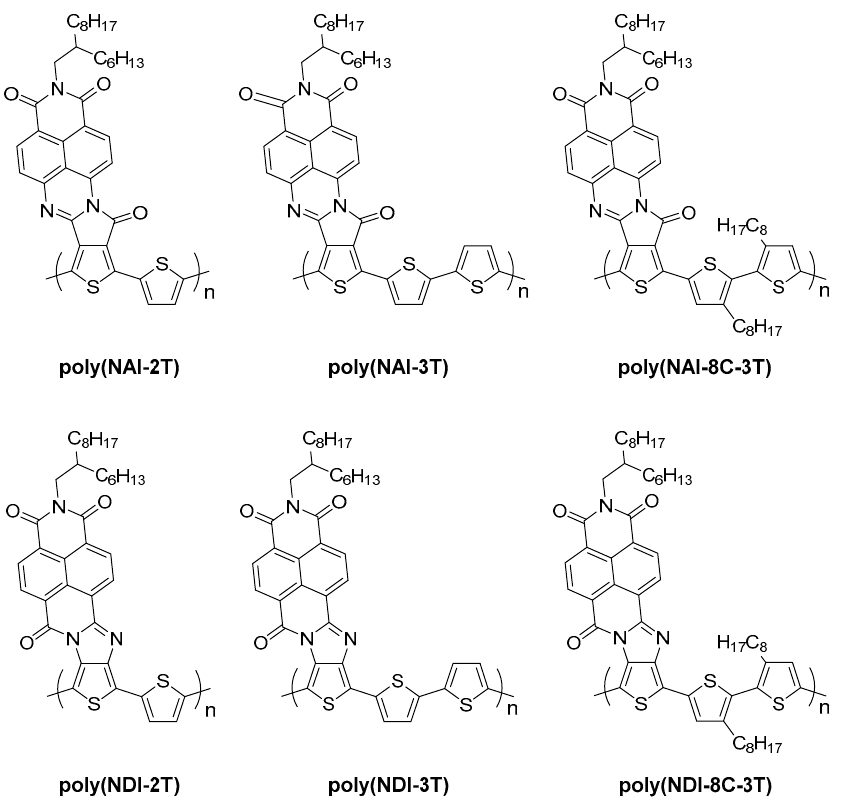
Figure 10. Different organic polymers based on NAI-nT and NDI-nT semiconductors. The polymers could be obtained by Stille cross-coupling reactions between NAI-1T- 2Br (Scheme 5) or NDI-1T-2Br (Scheme 3) and the corresponding thiophene or bithiophene bisstanannes. Due to the low solubility of poly(NDI-3T) and poly(NAI-3T) derivatives, alkyl chains were introduced in the bithiophene comonomer to obtain more processable materials, designated as poly(NDI-8C-3T) and poly(NAI-8C-3T) (Figure